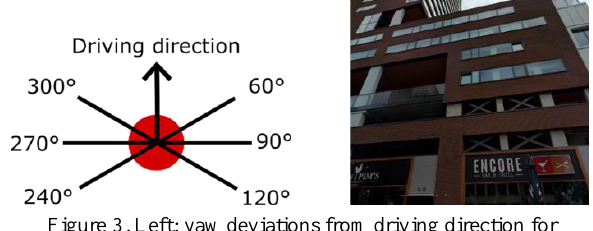
Figure 3. Left: yaw deviations from driving direction for perspective image creation. Right: Perspective image from panoramic image